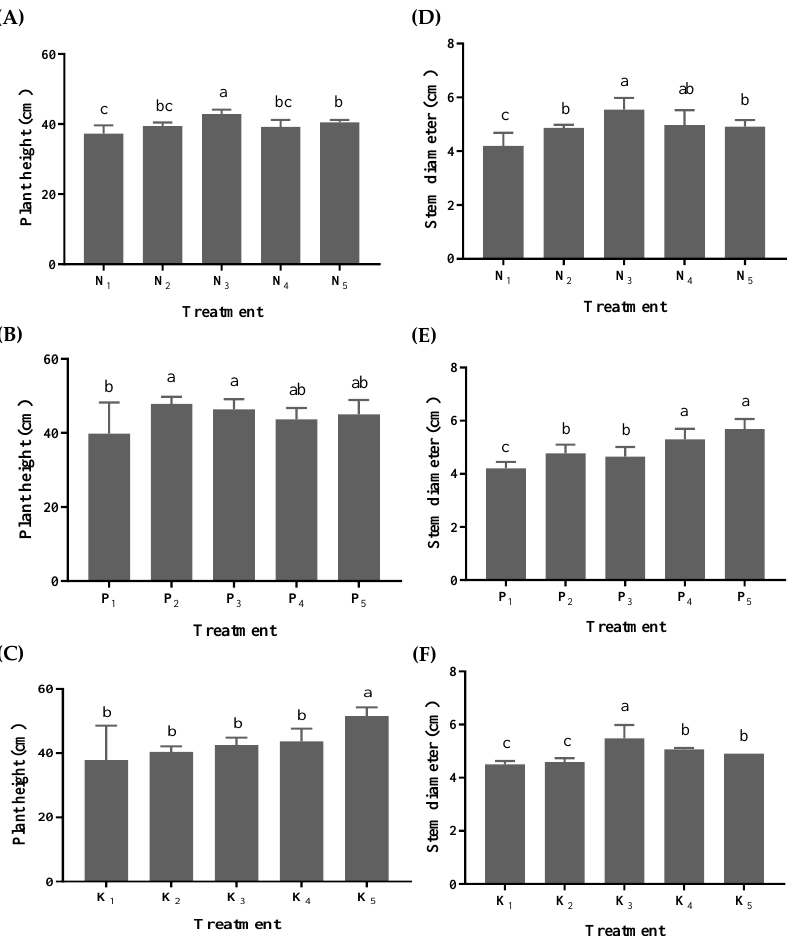
Figure 1. The plant height and stem diameter of lettuce under different application rates of N, P, and K. The lettuce plants were treated with five levels of N, P, and K fertilizers. Then, the plant height ( A – C ) and stem diameter ( D – F ) under N ( A , D ), P ( B , E ), and K ( C , F ) treatments were measured and recorded. Different letters indicate the distinct differences at p < 0.05.